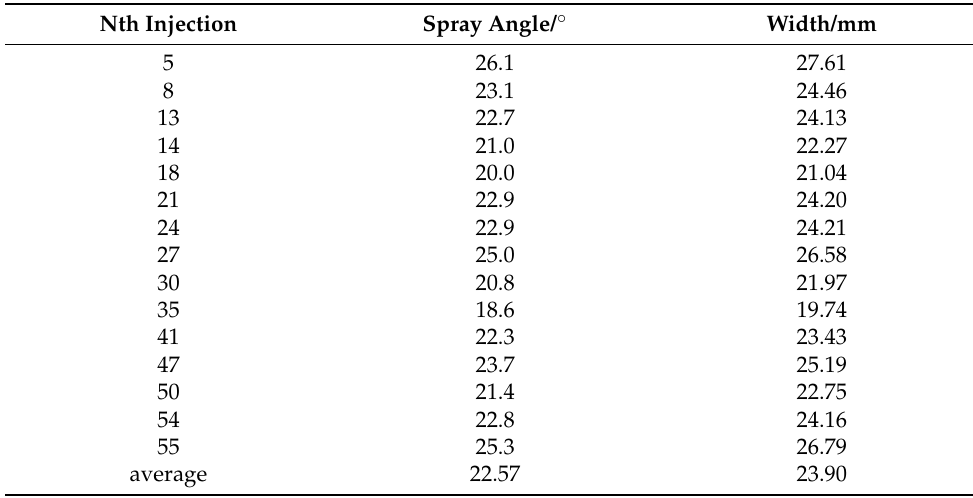
Figure 4. Measurement of geometric pattern.